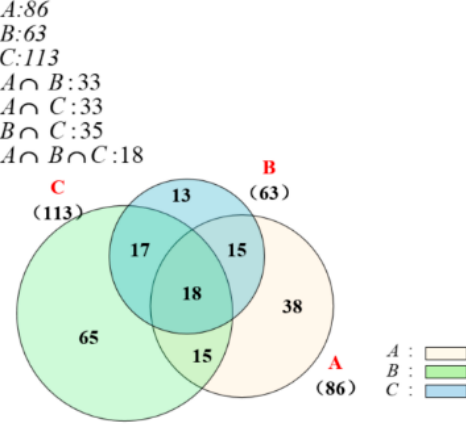
Figure 7. Case of area-proportional Venn diagrams.